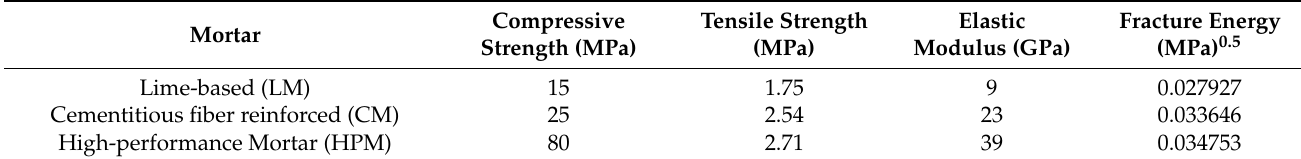
Table 1. The mechanical properties of mortars in FRCM systems